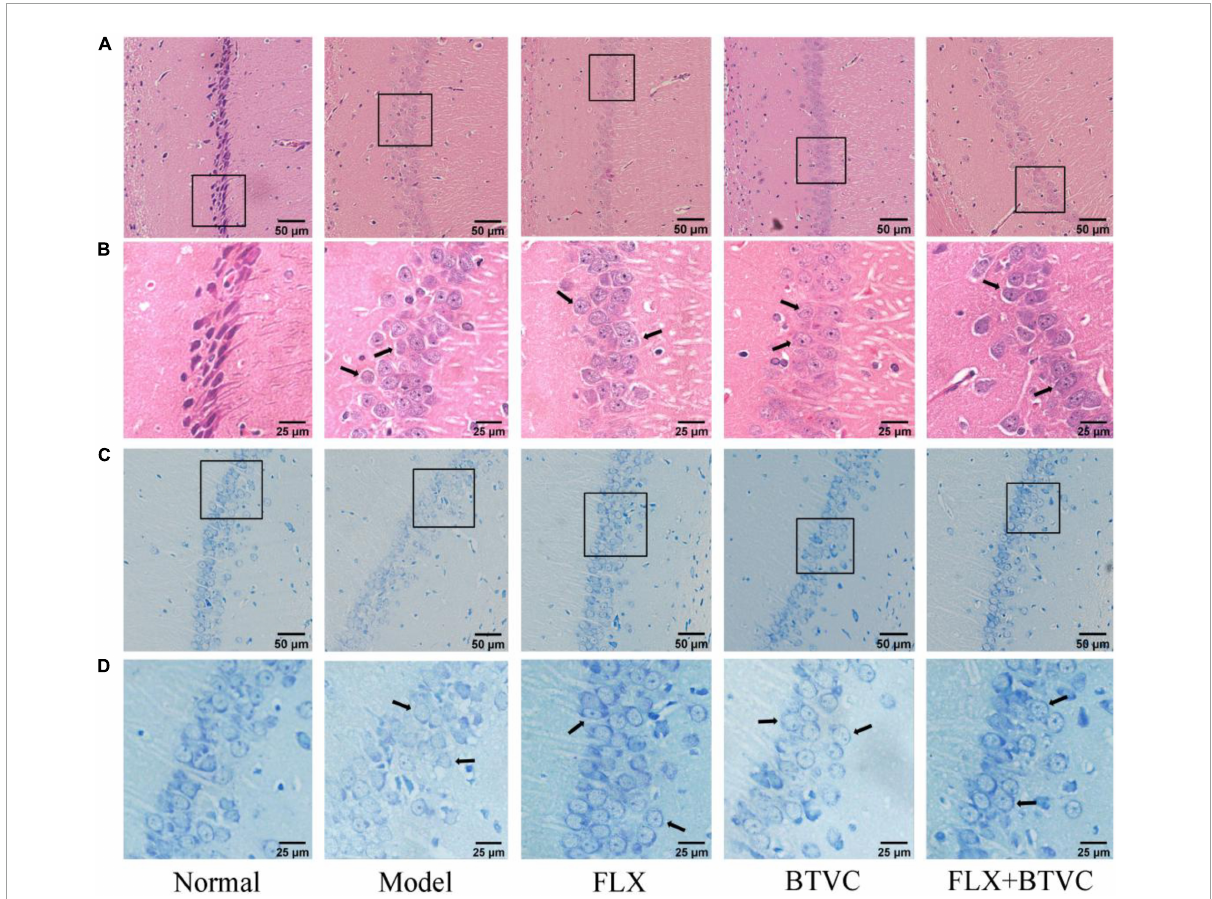
FIGURE3 Hematoxylin and eosin staining of rat hippocampus region of each group, (A) 100 × magnification, scale bar = 50 µ m, (B) 200 × magnification, scale bar = 25 µ m; Nissl staining of rat hippocampus region of each group, (C) 100 × magnification, scale bar = 50 µ m, (D) 200 × magnification, scale bar = 25 µ